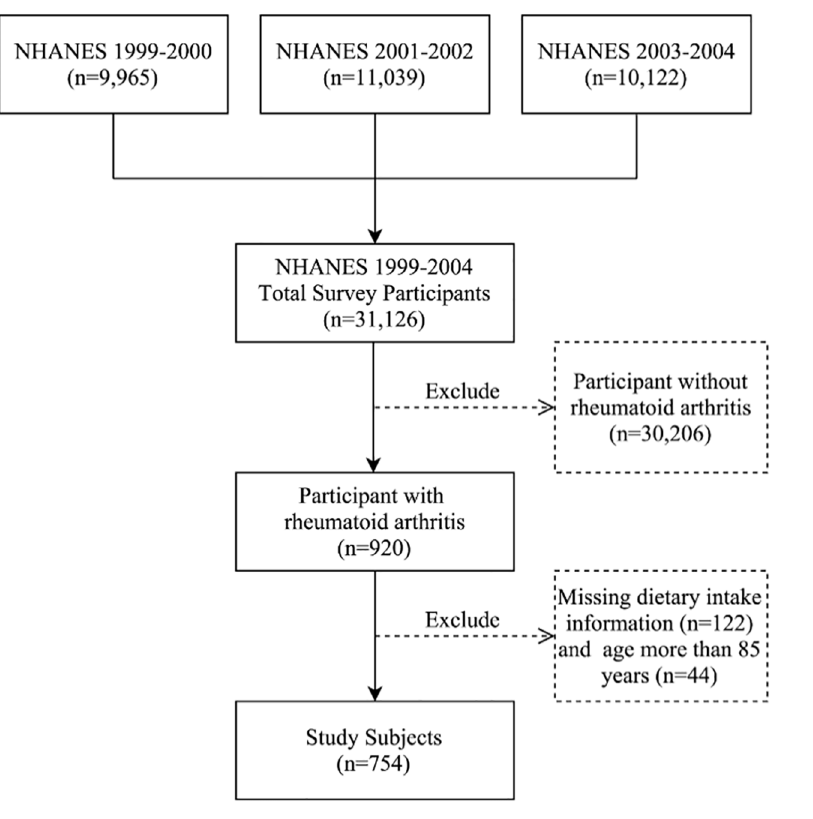
Fig 1. Flow chart for study subject